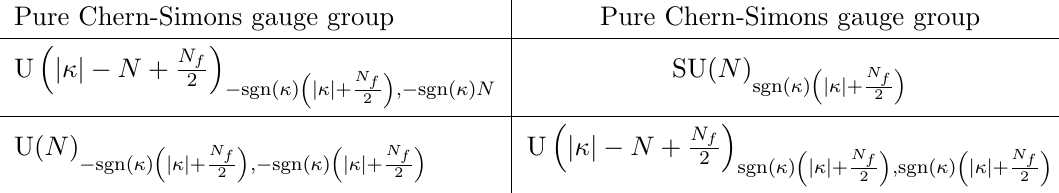
Table 4. By integrating out the remaining matter content from table 3, we obtain dual pairs of Pure Chern-Simons gauge